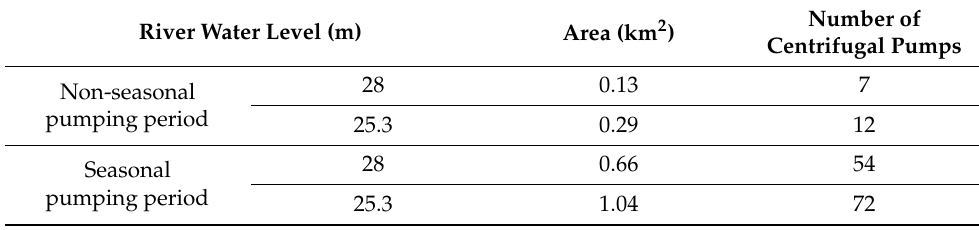
Table 3. Number of centrifugal pumps that became ineffective due to the opening of the weir (PAT ≤